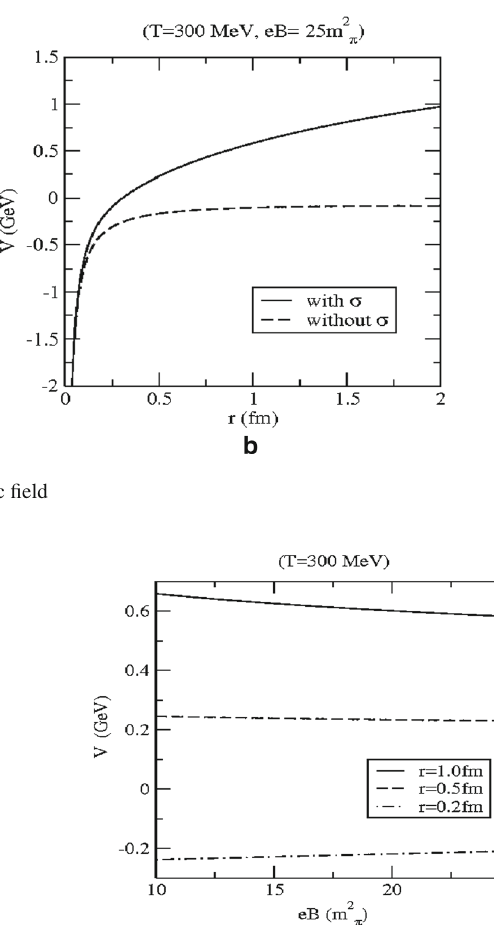
propagator and gluon self-energy at finite temperature in the strong magnetic field through the distribution